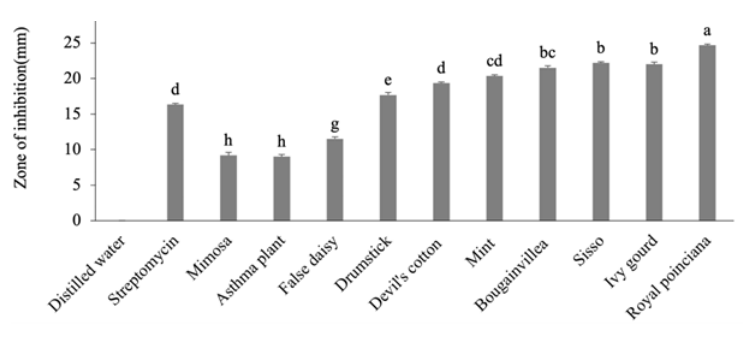
Figure 3 Antibacterial effect of 25% ethanol extracts of medicinal plants. e letters represent the significant effects of plants on each other. e whiskers above the bars represent standard error ( SE ).